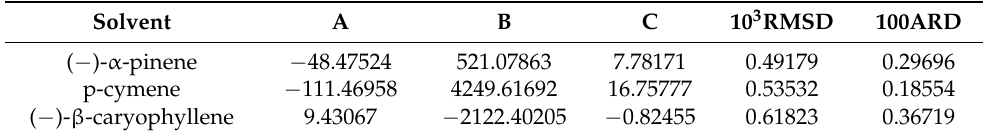
Table 4. Regression results and model parameters of the modified Apelblat model of dehydroabietic acid in